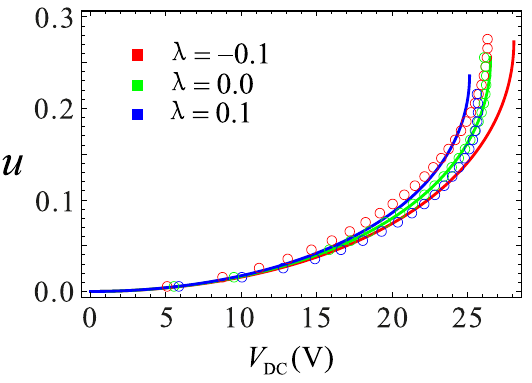
Figure 14. Relationship between DC voltage and static equilibrium point under different section parameters. The solid lines represent the analytic solutions. The circles represent the finite element solutions.